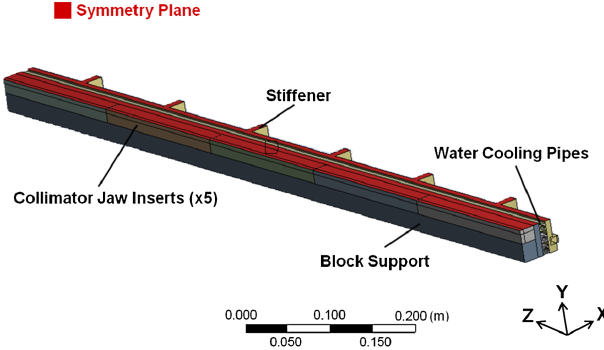
FIG. 6. 3D model of the lower symmetrical half of the right jaw assemblyofaTCT.The symmetryplane (x-zplane)isshowninred.